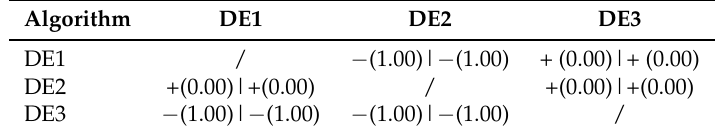
Table 2. Extension of Deep Statistical Comparison (eDSC) analysis at D *1000 function evaluations (FEs).